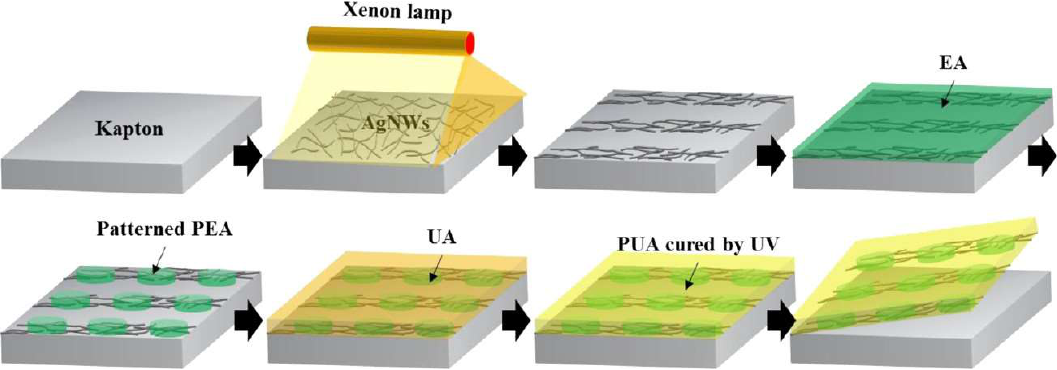
Figure 7. Scheme showing the fabrication of a heterogeneous Ag NW/polymer composite structure. Reprinted from [44], with permission from American Chemical Society, 2017.